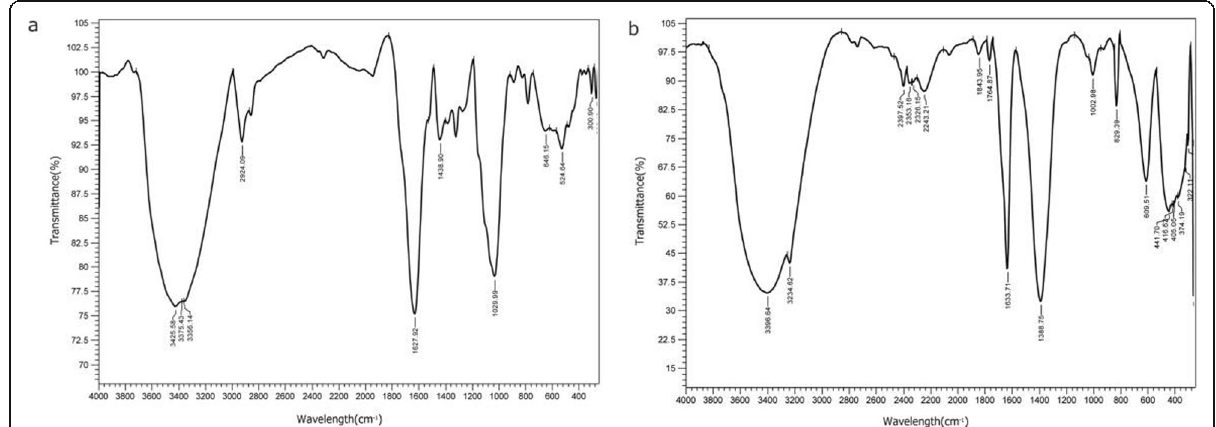
Fig. 3 a FTIR image of Pterocarpus marsupium heartwood aqueous extract. b FTIR image of Pterocarpus marsupium synthesized MgO nanoparticles